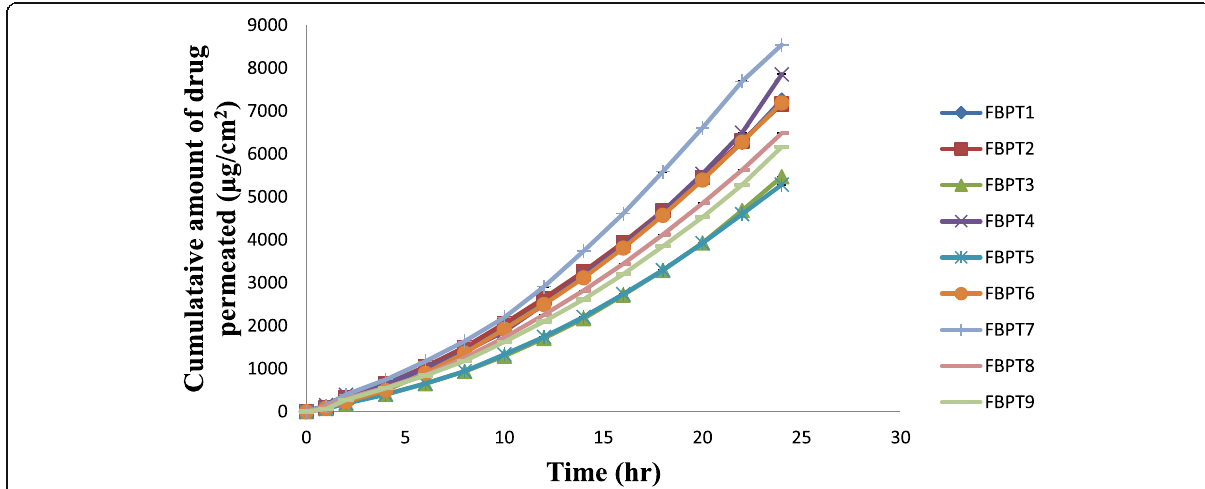
Fig. 8 Ex vivo drug permeation profile of flurbiprofen from transdermal films (FBPT1-FBPT9)